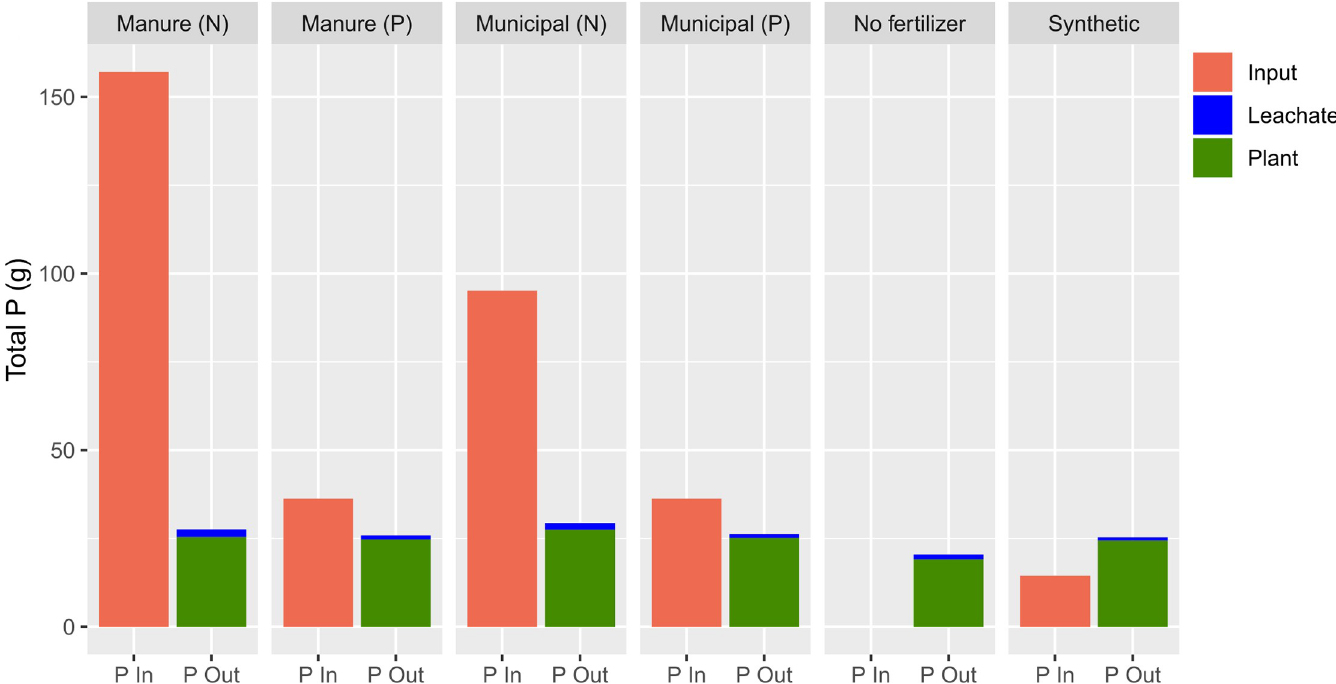
Fig 3. Mass balance at plot level (of 4 m 2 ) showing mean P inputs, mean P export via plant harvest, and loss via dissolved inorganic P in leachate.